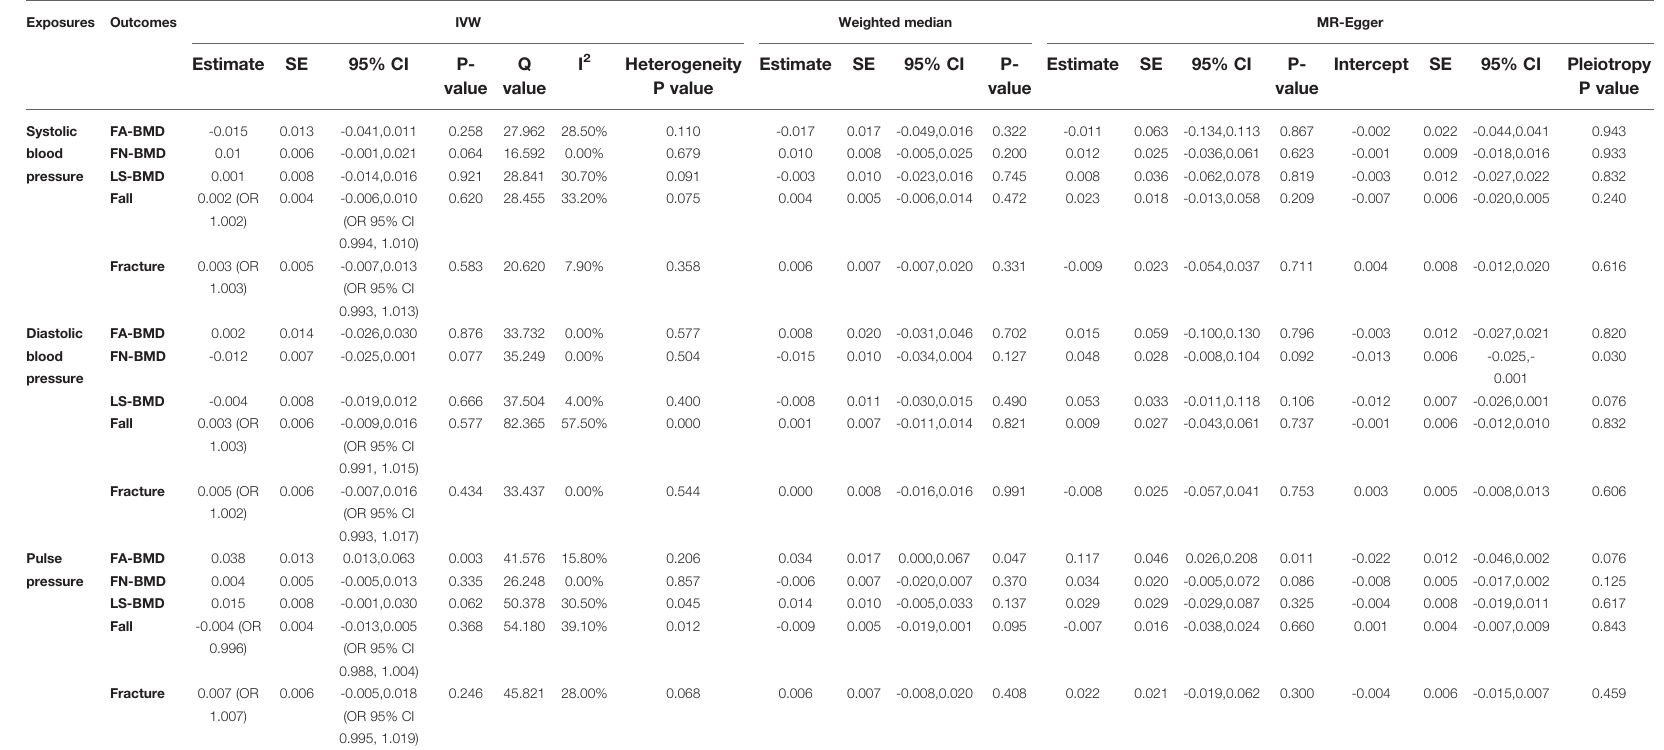
TABLE 1 | Mendelian randomization estimates of blood pressure on